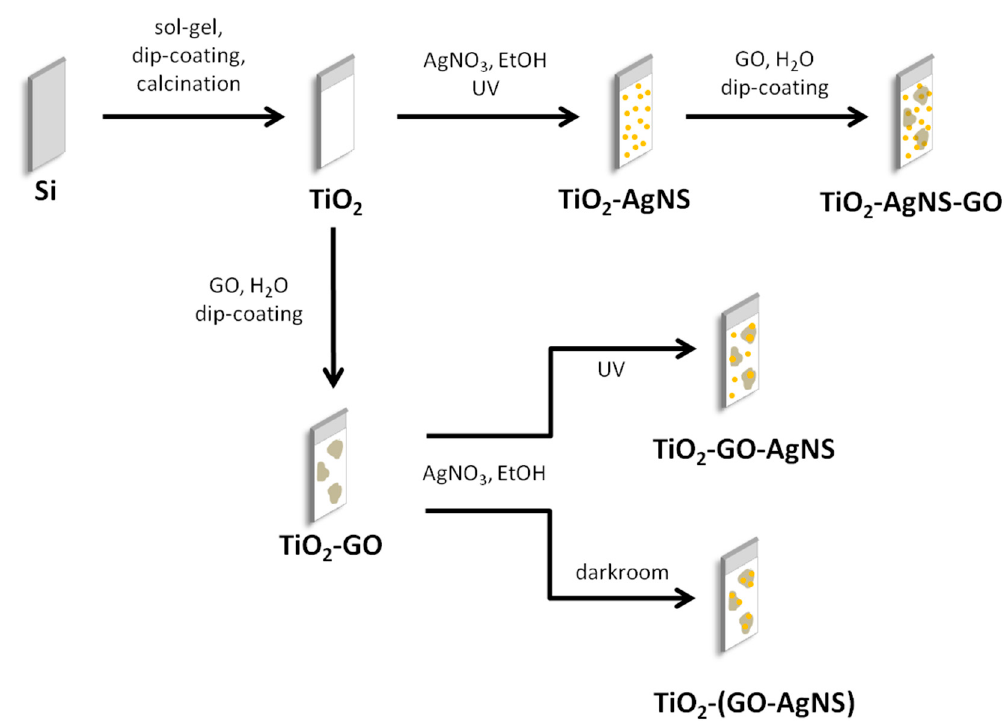
Figure 1. The schematic illustration of the preparation steps of photocatalysts with di ff erent surface architecture.